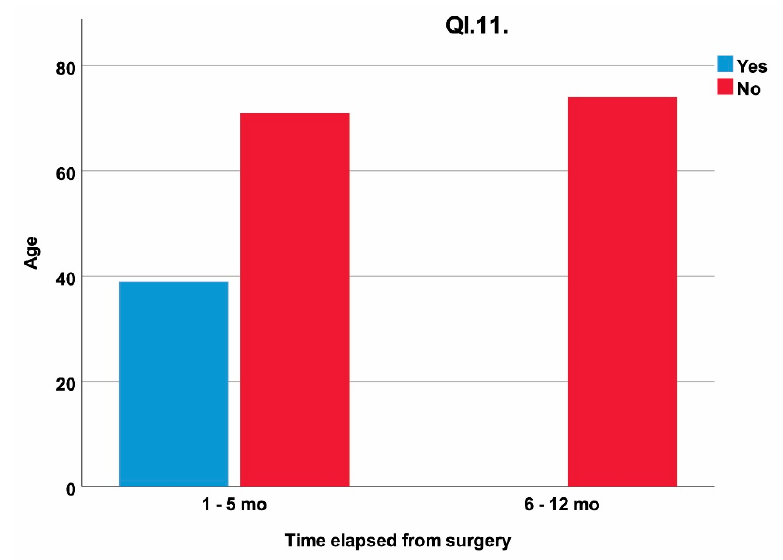
Figure 5. The influence of patient’s age and time elapsed from surgery on the response at QI.11 (“Do you feel pain when moving your lower jaw back and forward, without opening your mouth?”); mo = months.